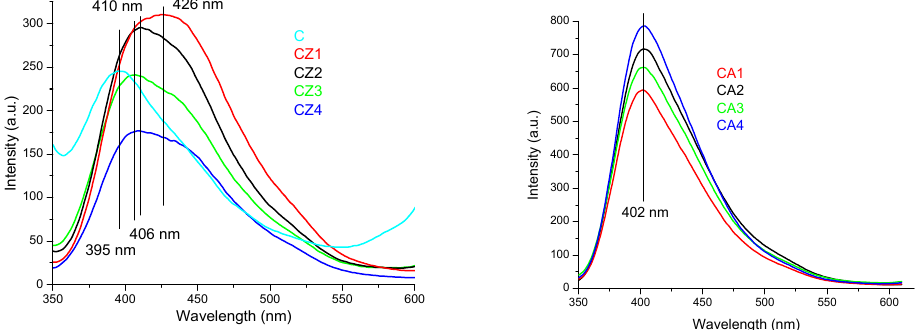
Figure 6. The PL spectra for chitosan and CZ1–CZ4 films ( left ) and CA1–CA4 films ( right ). The fluorescence spectra of CA1–CA4 films are presented in Figure 6 (right). The fluorescence band appear at 402 nm, is attributed to the chitosan. Even for CA1 sample, which has the lowest Ag NPs content, the band is over two times more intense than for simple chitosan film. The increasing Ag NPs content of CA4 leads to the enhancing of the violet emission of the sample, more than three times when compared with control chitosan sample. The band has an asymmetrical tail towards blue region (500